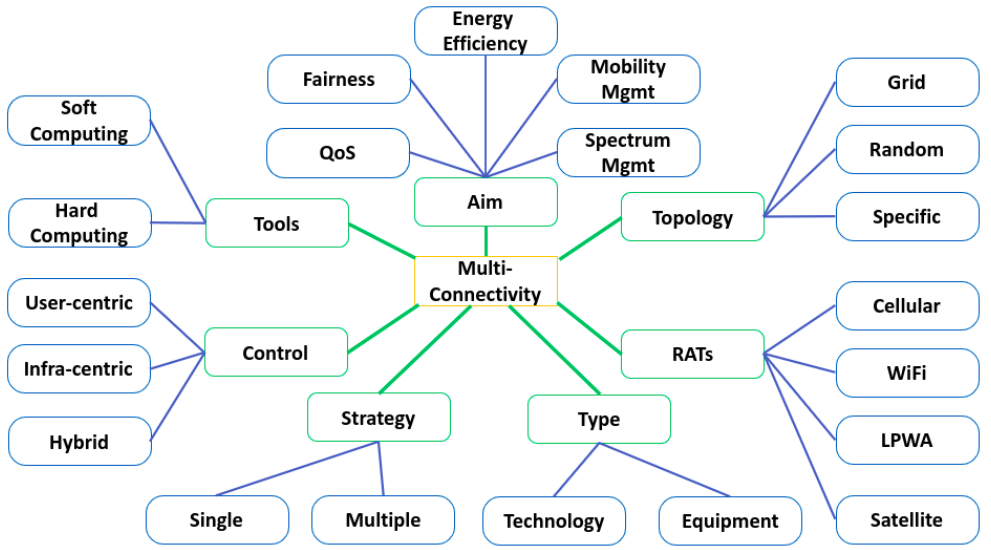
Figure 2. Taxonomy for multi-connectivity in 5G networks and